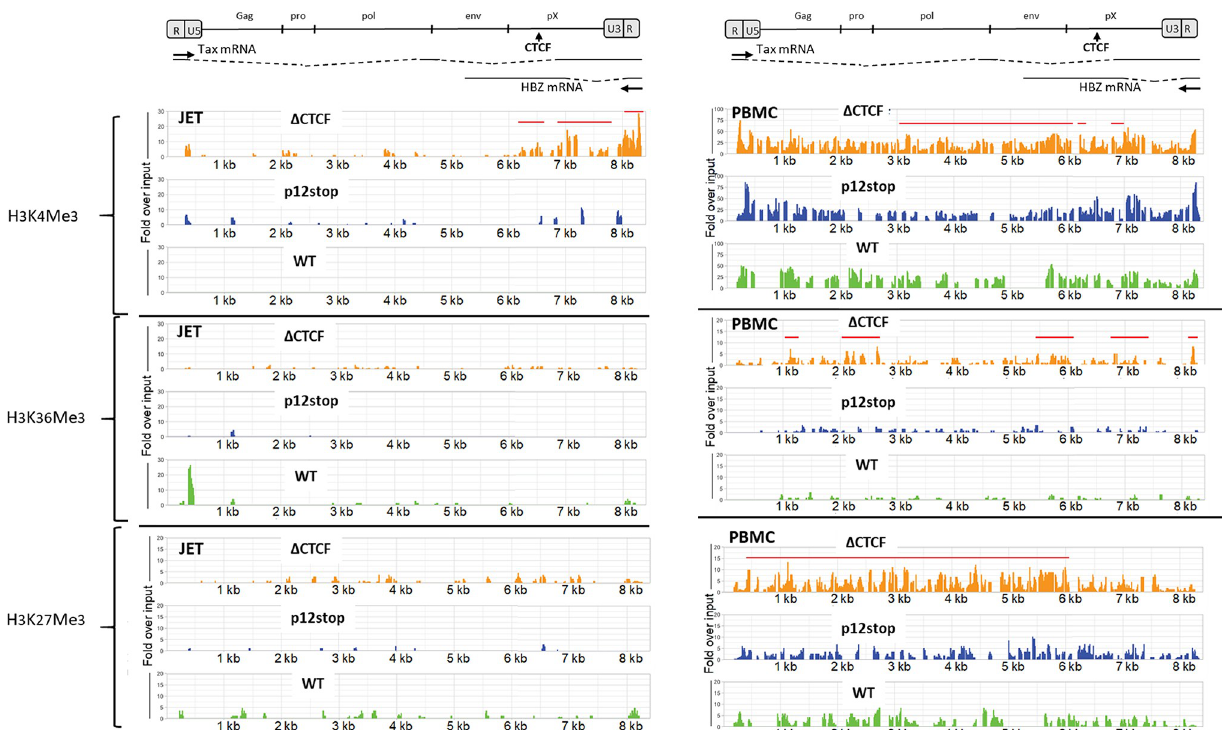
Fig 3. Histone methylation is increased in HTLV-1 Δ CTCF. Plots show fold enrichment over input for the indicated chromatin modifications on HTLV-1 provirus DNA in the bulk populations of JET cells (left) or PBMCs (right). Cells infected with HTLV-1 Δ CTCF (orange), HTLV-1-p12stop (blue), or WT HTLV-1 (green) virus were subjected to chromatin immunoprecipitation for H3K4Me3, H3K36Me3 or H3K27Me3. Called peaks in HTLV- 1 Δ CTCF that are significantly different from both HTLV-1p12Stop and WT HTLV-1 are indicated by horizontal red lines.